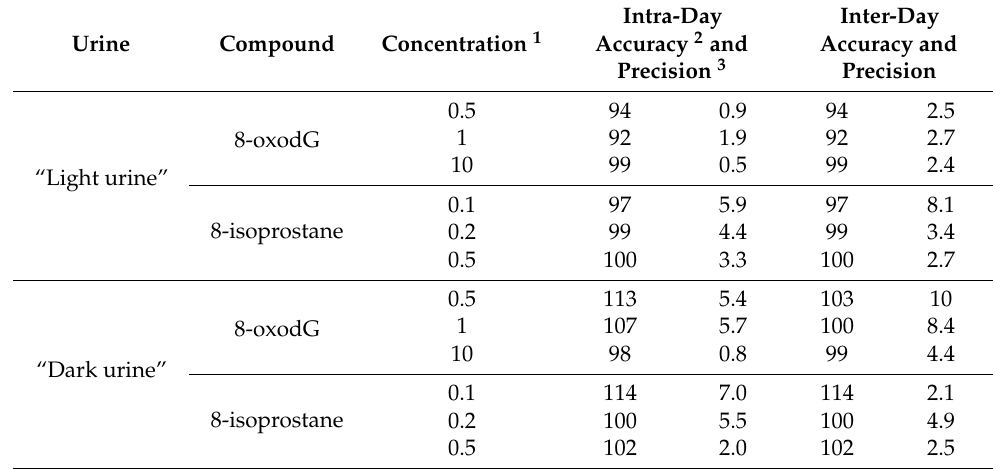
Table 3. Accuracy and precision for 8-oxodG and 8-isoprostane at three concentrations in two different urine